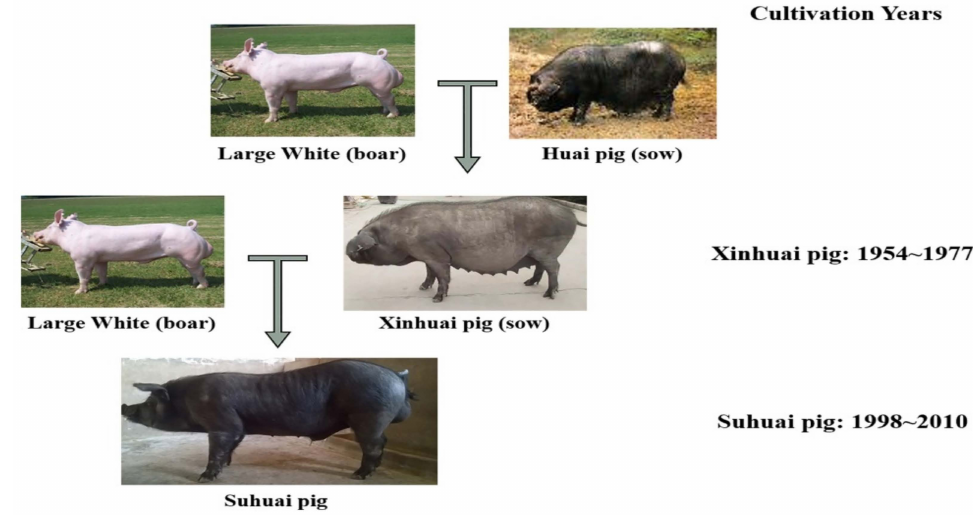
Figure 1. The cultivation process of Suhuai